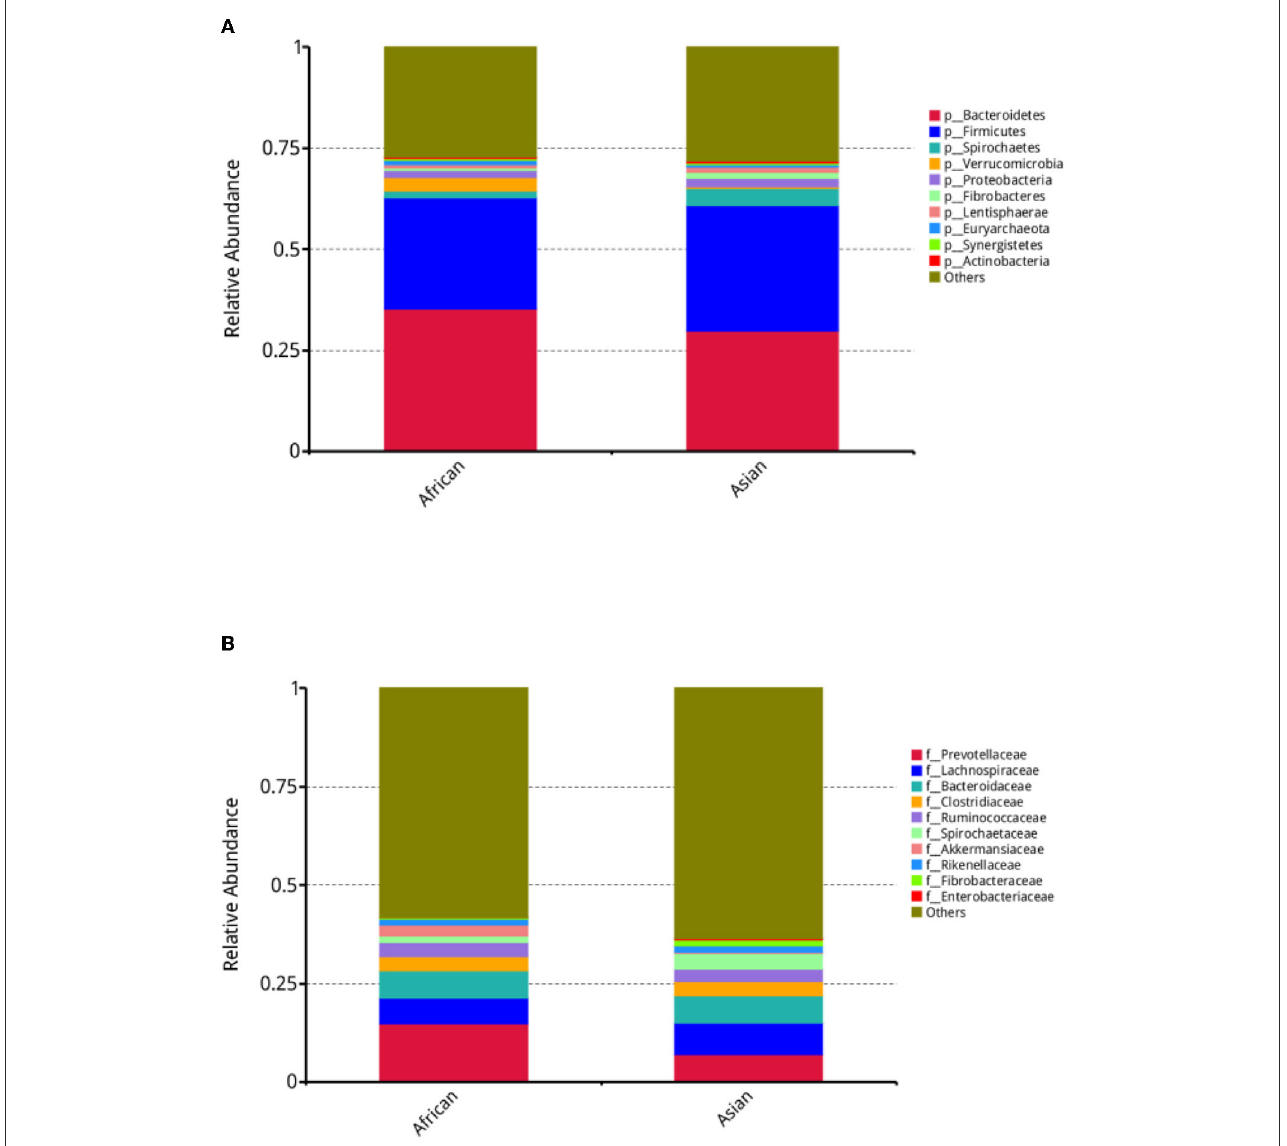
FIGURE2 (A) Stacked bar plot depicting relative abundance of top ten bacteria phyla; (B) Stacked bar plot depicting relative abundance of top ten bacteria families in African ( n = 3) and Asian ( n = 4) elephants.